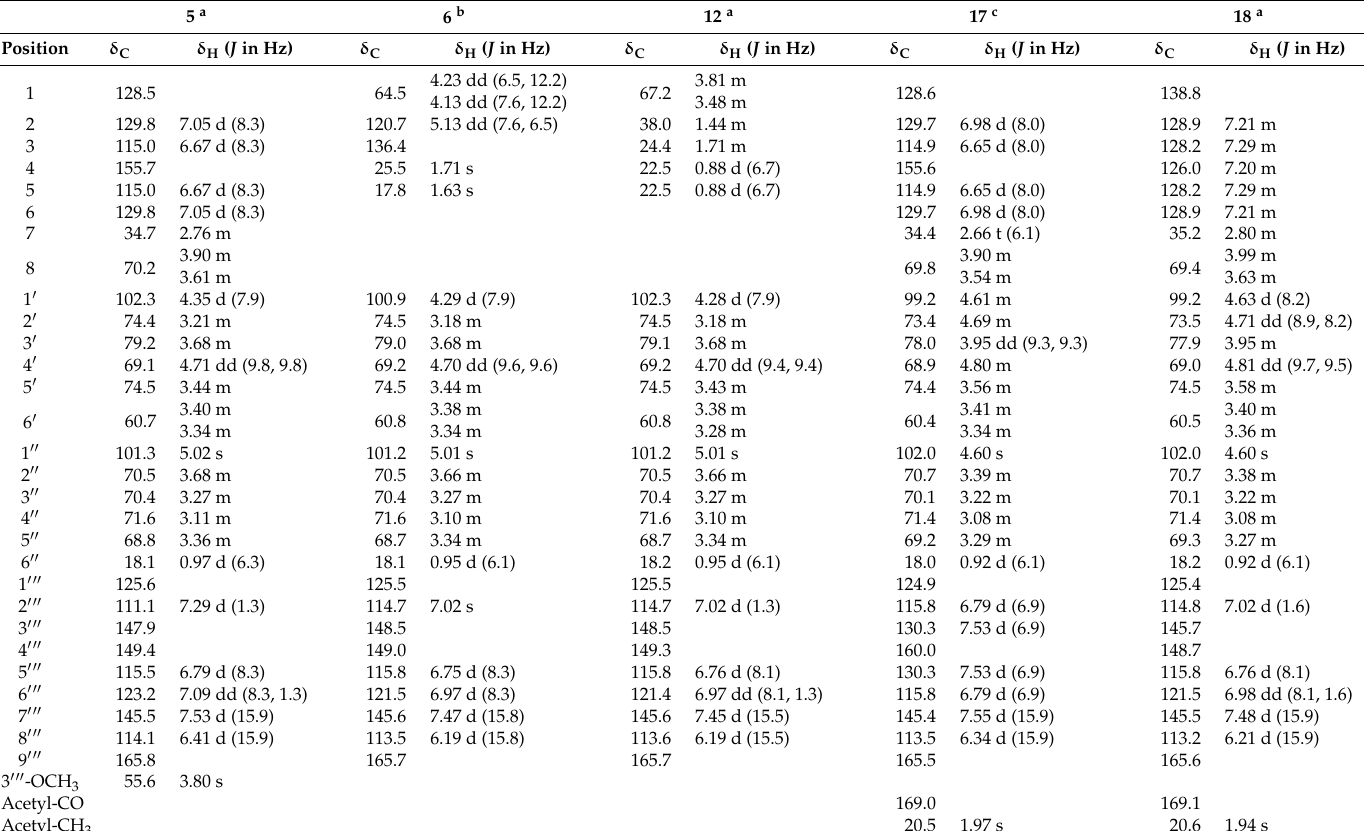
Table 2. 1 H and 13 C-NMR Data of new compounds (DMSO- d 6